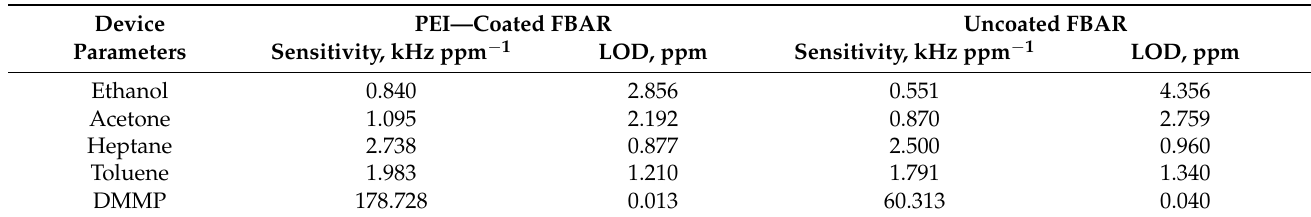
Table 1. Sensitivity and LOD Parameters for FBAR detectors in the detection of five